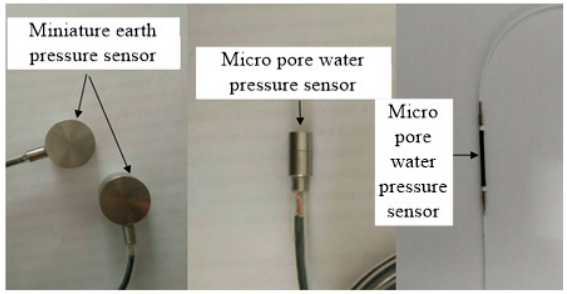
Figure 3. Photographs of the three sensors used in the experiments.